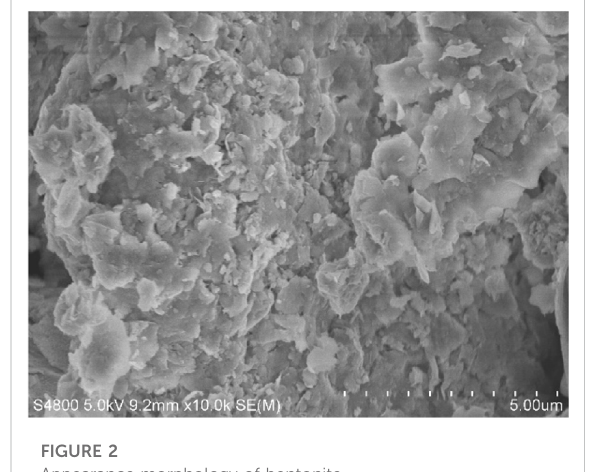
FIGURE 2 Appearance morphology of bentonite.